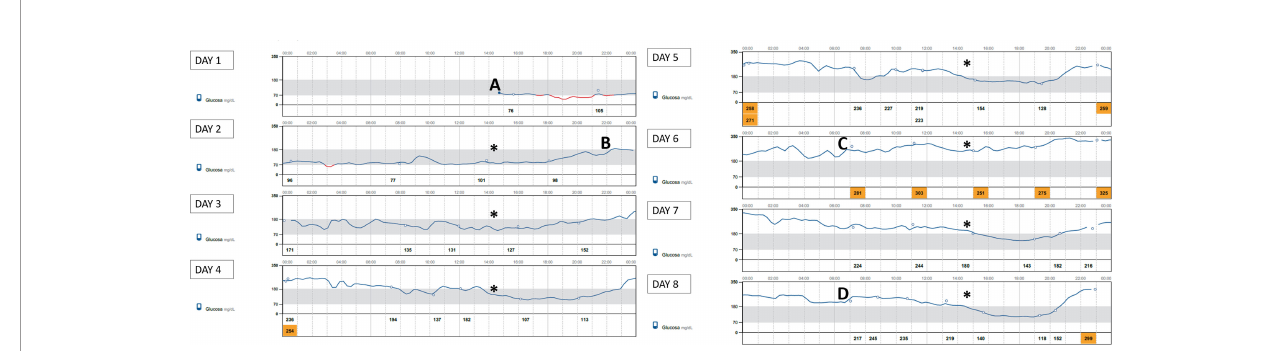
FIGURE 1 | FreeStyle Libre 2 ® Abbott Glucose Monitoring (LibreView system) following start of alpelisib (A) Alpelisib start (300 mg/daily); (B) Metformin 850 mg daily addition; (C) Alogliptin 25 mg and pioglitazone 30 mg daily addition; (D) insulin addition, *Alpelisib daily